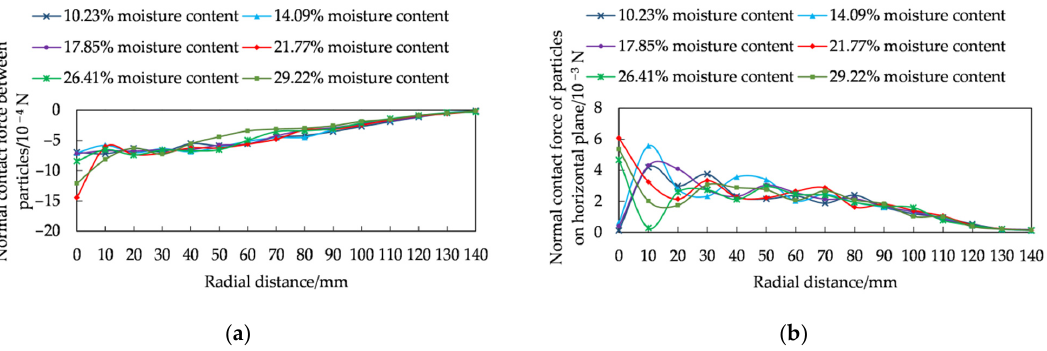
Figure 5. Analysis of mechanical characteristics of rice seeds in quasi-static accumulation stage: ( a ) normal contact force between rice seeds, ( b ) normal contact force on horizontal surface.